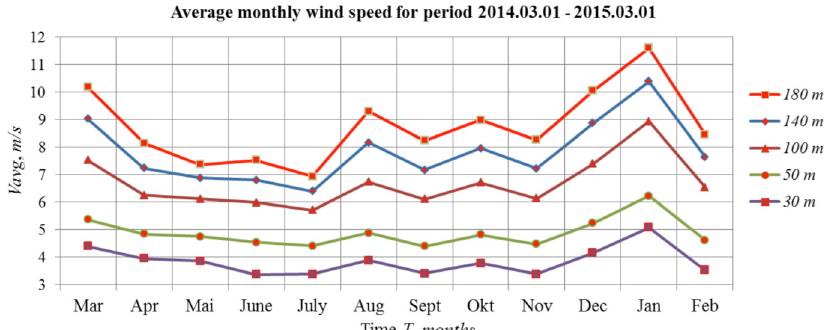
Fig. 2. Distribution curves of the average wind speed values V avg (m/s) obtained using the laser measuring complex Pentalum SpiDAR for the heights 30, 50, 100, 140 and 180 (m) above ground in the measurement time T .